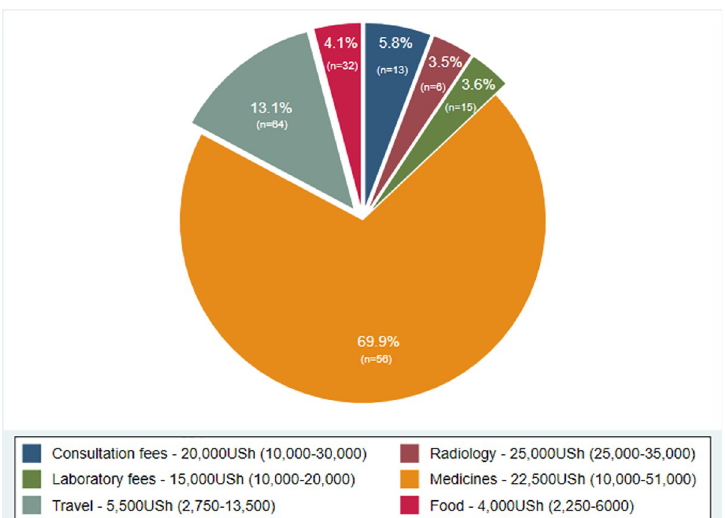
Fig 4. Distribution of direct costs during facility visits by study participants. Direct costs incurred in 83 facility visits by the 31 study participants who returned to healthcare after TB evaluation. Slices represent the percentage of overall direct costs incurred by study participants by cost category (percentages labelled). The number of visits in which the specified cost category was accessed is also shown on the slices in brackets. The inner legend shows the median and inter-quartile range (in brackets) spent in that cost category, when